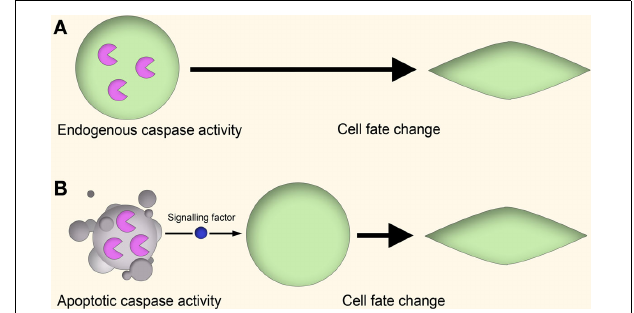
FIGURE 1 | Cell-autonomous vs. non-cell-autonomous models of caspase signaling. (A) Cell-autonomous model. In the proliferating cell, a non-apoptotic caspase signaling pathway leads to a change in cell behavior through modulation of gene expression, cytoskeletal restructuring, or other means. This signaling is endogenous to the proliferating cell itself, and no apoptotic cell signaling is involved. (B) Non-cell-autonomous model. In this model, caspase activity within apoptotic cells lead to the generation of signaling factors which stimulate the cell behavior change of nearby cells in a paracrine